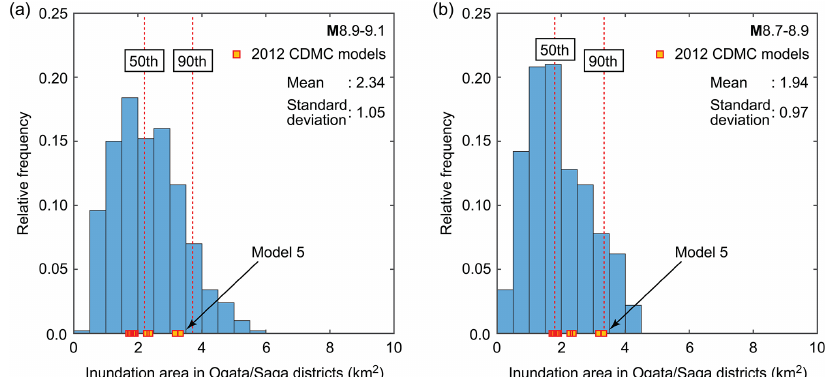
Figure 12. Histograms of inundation areas in the Ogata and Saga districts for the two magnitude ranges M 8.9–9.1 (a) and M 8.7–8.9 (b) . In each figure panel, inundation areas that are used to define local critical tsunami scenarios are indicated by the 50th and 90th percentile lines. The sum of the vertical bin heights is